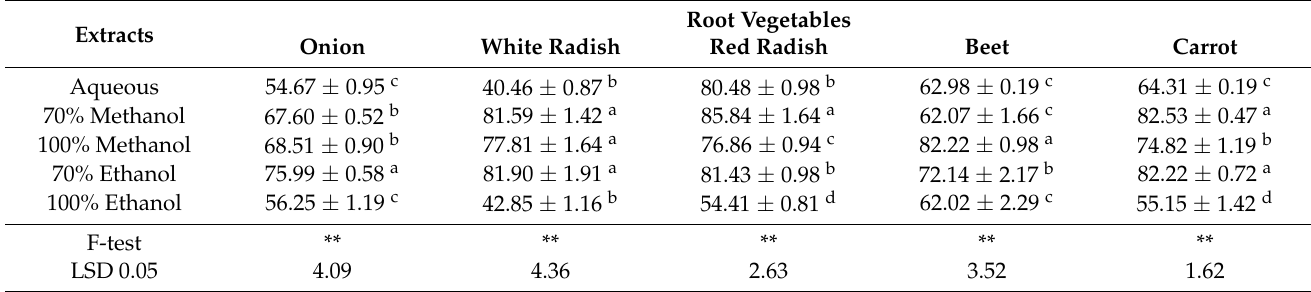
Table 1. DPPH scavenging activity (%) of the aerial part of selected root